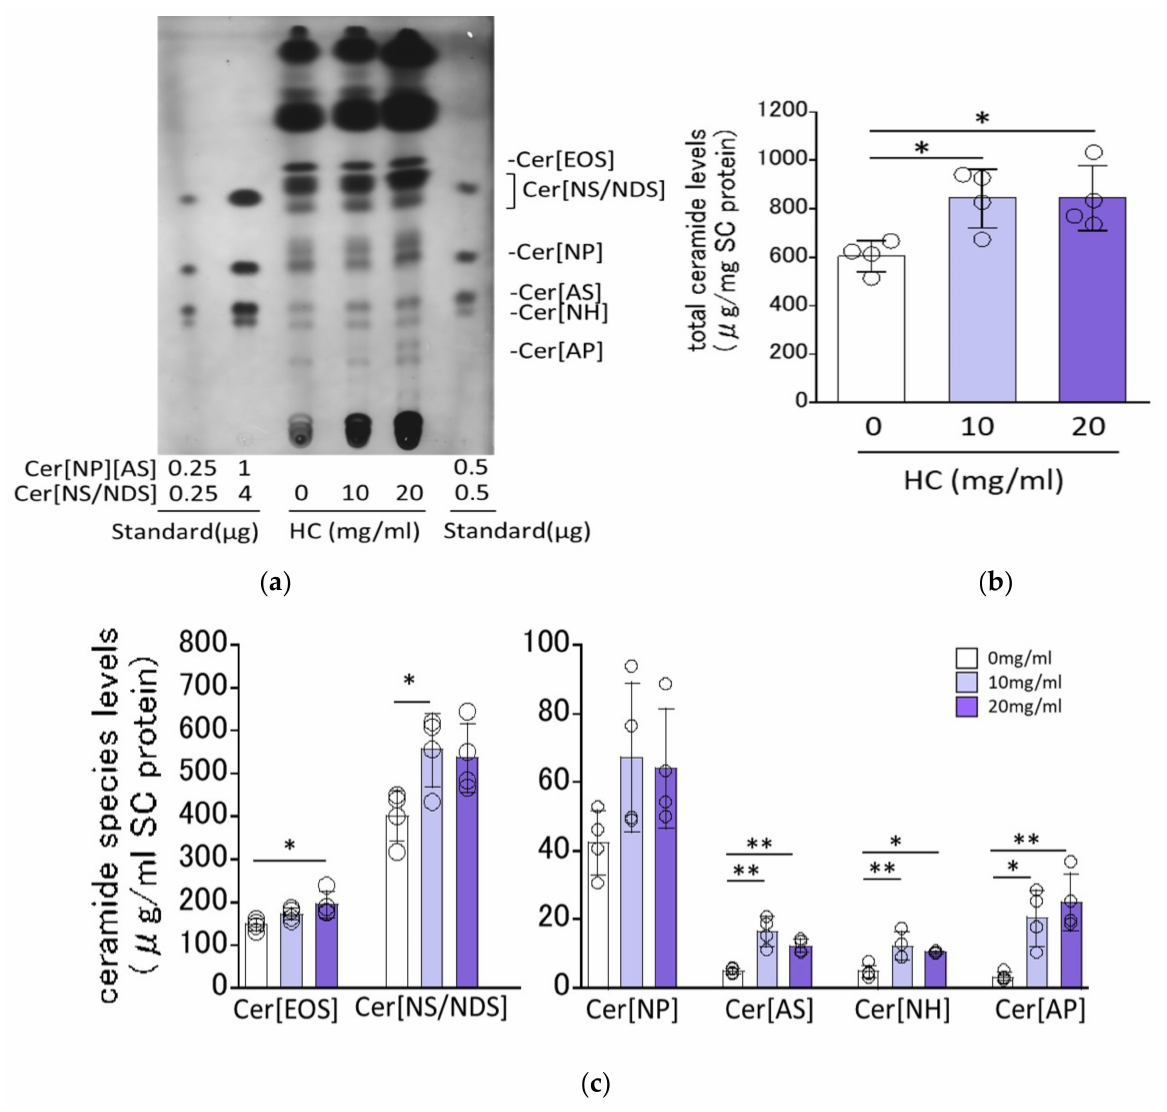
Figure 2. Effect of HC on SC ceramide levels in RHEEs. ( a ) HPTLC chromatogram. ( b ) Levels of total ceramides. ( c ) Levels of ceramide species. RHEEs were treated daily with HC (at 0, 10 and 20 mg/mL) for 10 days and the SC was separated from the epidermis after which total lipids were extracted as described in the Section 4 Materials and Methods. Total lipids extracted were subjected to HPTLC analysis. Ceramide contents are expressed as µ g/mg SC protein. Bars represent mean ± SD, n = 3, Dunnett’s multiple comparison test. *: p < 0.05, **: p <